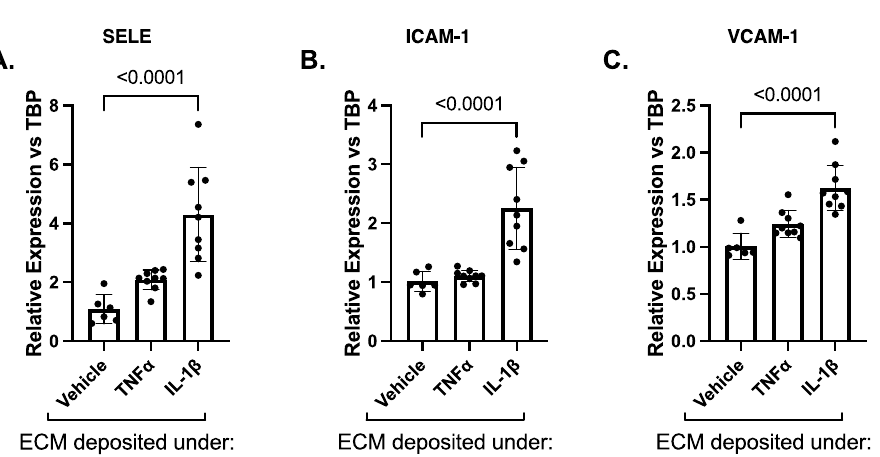
Figure 2. ECM deposited by cytokine-treated hRMEC causes induction of adhesion molecules in naïve hRMEC. Naïve hRMEC were plated onto ECM derived from TNFα- or IL-1β-treated hRMEC. Cells were collected and assayed for expression of ( A ) E-selectin (gene name: SELE), ( B ) ICAM-1, or ( C ) VCAM-1. Expression data are reported as fold induction over vehicle with bars representing mean ± SD (vehicle: n = 6; TNFα: n = 9; IL-1β: n =